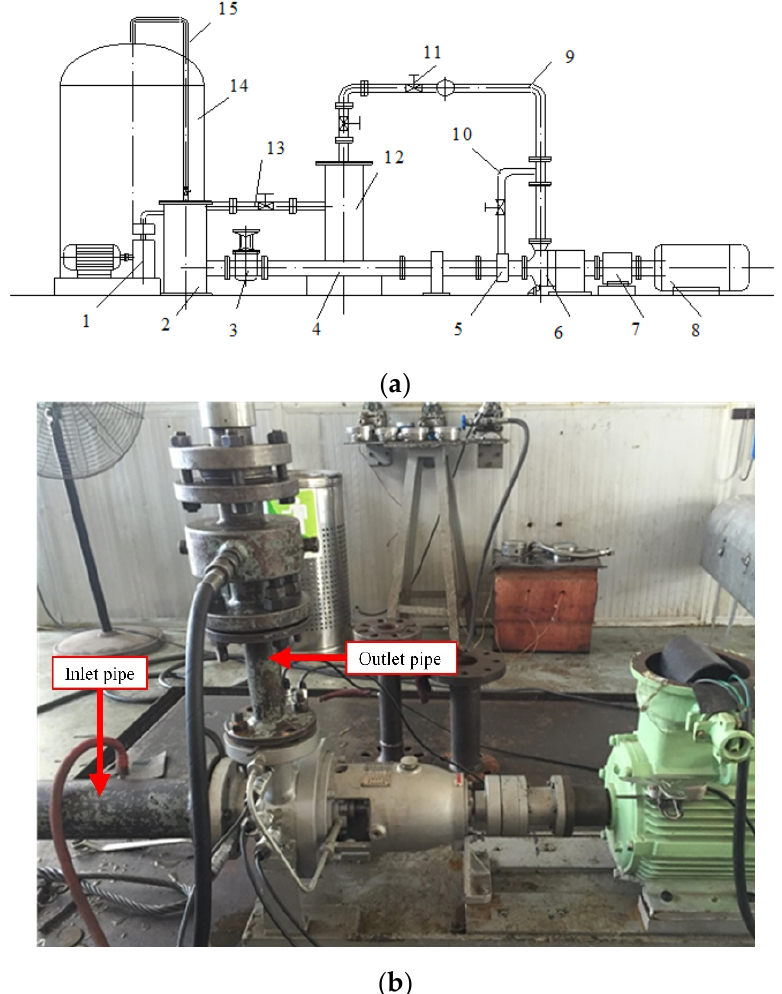
Figure 3. Test-loop system: ( a ) Sketch map of the experimental system; ( b ) Test centrifugal pump.